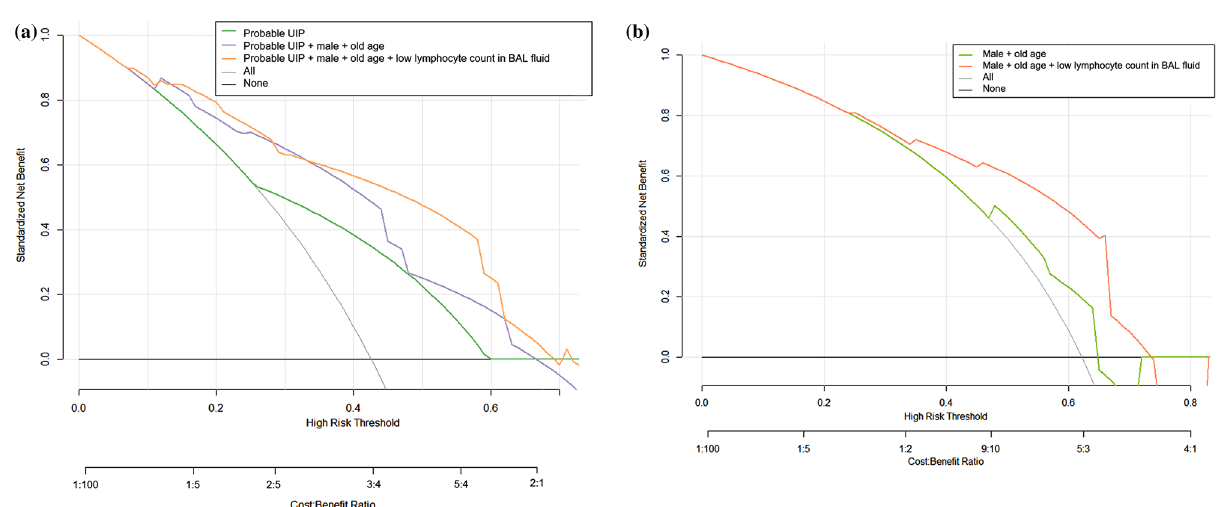
Figure 3. Decision curve analysis of prediction models for the diagnosis of idiopathic pulmonary fibrosis in patients with non-definite CT pattern in the validation cohort. ( a ) Net benefits (proportion of true-positive results minus weighted proportion of false-positive results with weight equal to the ratio of risk threshold to 1 minus risk threshold) of combined model of probable UIP CT pattern, demographic characteristics (sex and age) plus low lymphocyte count in bronchoalveolar lavage fluid were comparable to or higher than those of models with CT pattern alone or combined with age and sex for risk thresholds > 15% in patients with CT pattern of non-definite UIP in the validation cohort. ( b ) Net benefits of combined model of demographic characteristics (sex and age) plus low lymphocyte count in bronchoalveolar lavage fluid were higher than those of models with demographic characteristics alone for risk thresholds > 20% in patients with CT pattern of probable UIP in the validation